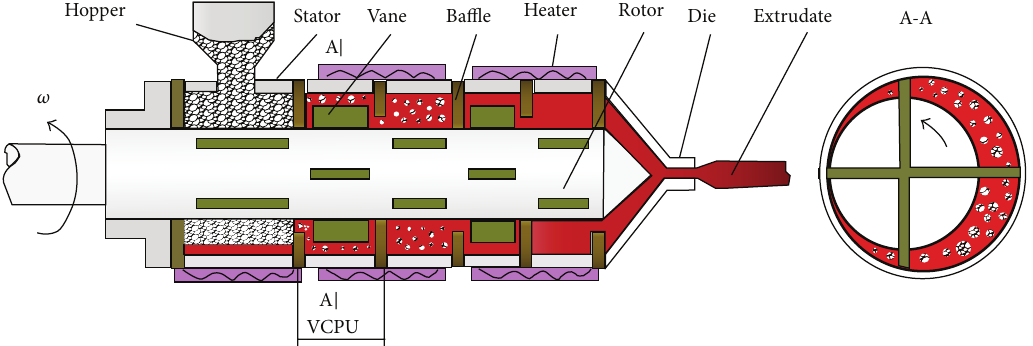
Figure 1: The schematic diagram of the novel extruder.